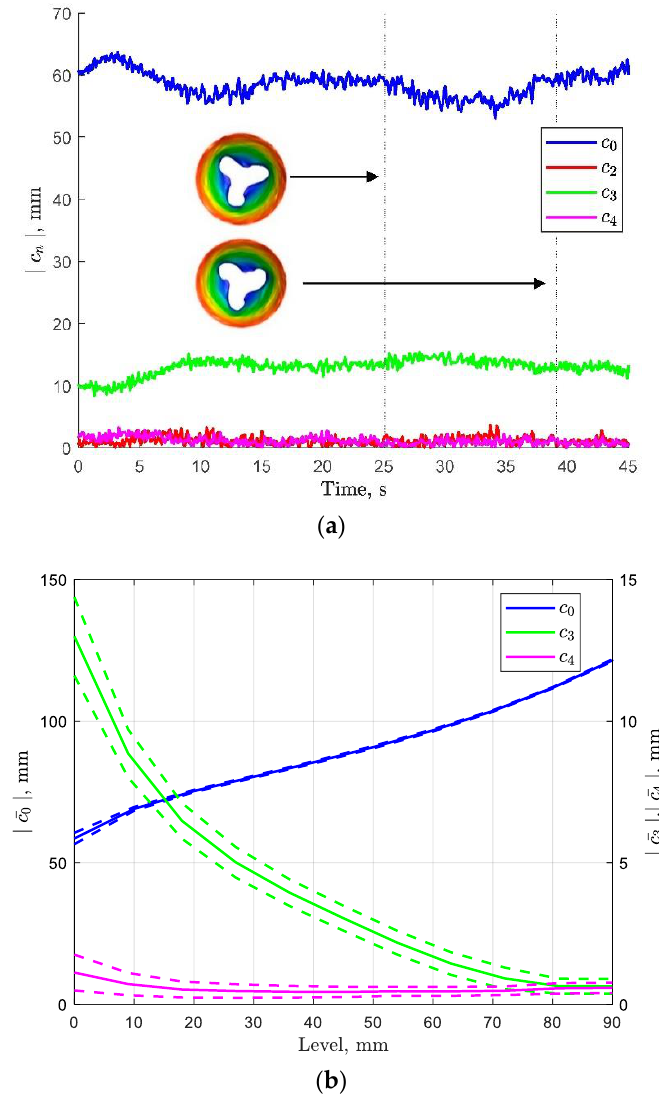
Figure 14. The Fourier coefficients, c 0 to c 4 , for 4.6 Hz rotating disk frequency: ( a ) the Fourier coefficients as function of time at the surface of the rotating disk. ( b ) The average and standard deviation of the Fourier coefficients for the time interval presented in ( a ) at different heights above the rotating disk. The left vertical axis corresponds to c 0 and the right vertical axis corresponds to c 2 and c 3 .